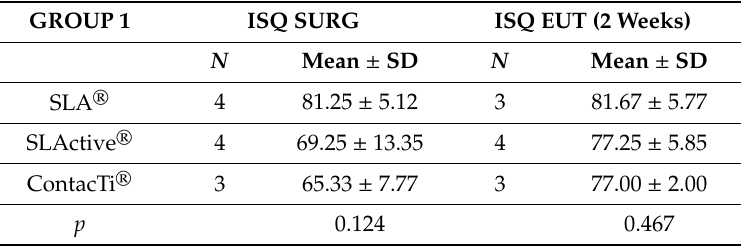
Table 1. Relative means of the ISQ value in the measurements performed in group 1 (euthanasia at 2 weeks), both on the day of surgery (ISQ SURG) and at the time of euthanasia (ISQ EUT), for each of the three groups.